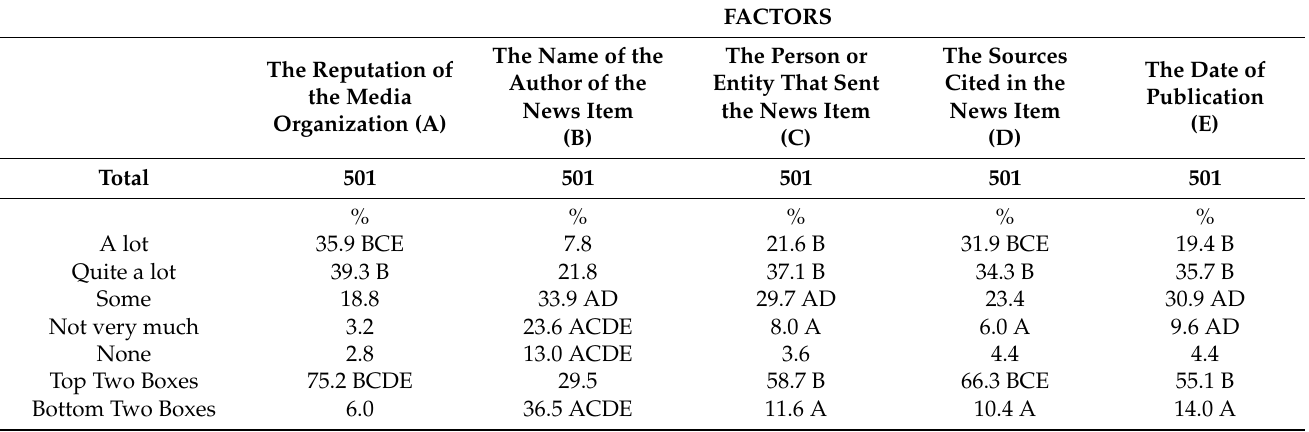
Table 13. Question 8: Think of the moment when you are reading a news item that you have searched for or have been sent. How much importance do you attach to each of the following in order to know whether the news item is true or fake? (Rotate items and show